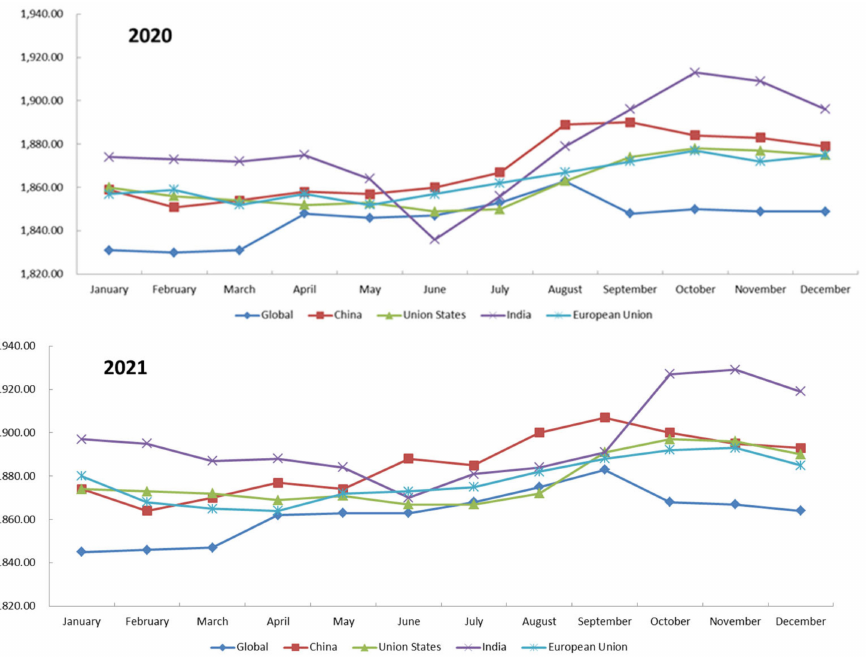
Figure 7. Monthly average CH 4 concentrations for global land and major countries/regions in 2021.